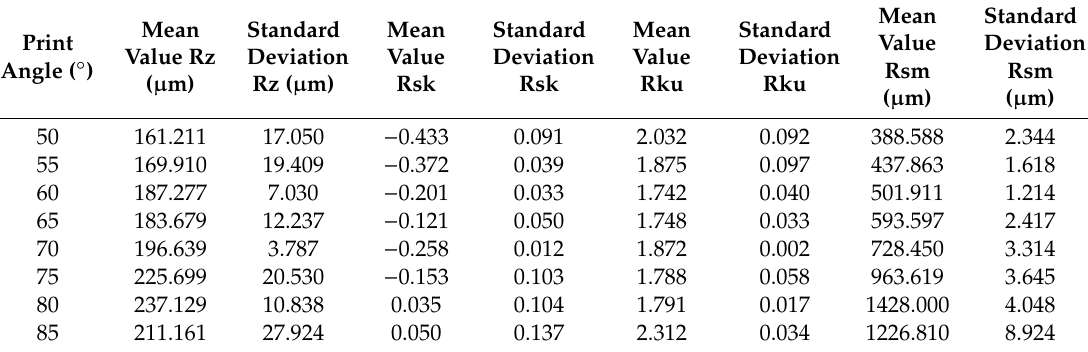
Table 2. Rz, Rsk, Rku, and Rsm